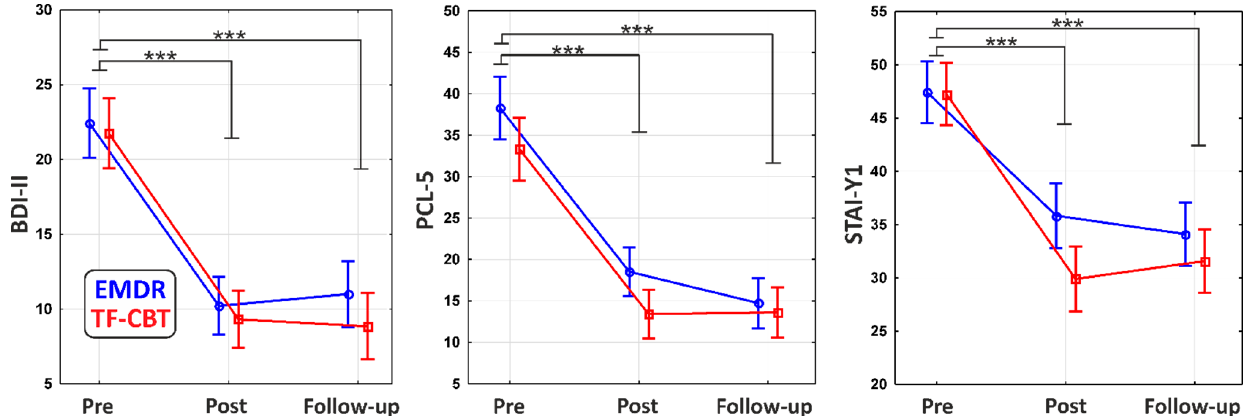
Figure 1. Mean scores of the Beck Depression Inventory-II (BDI-II, left ), post-traumatic stress disorder checklist for DSM-V (PCL-5, middle ) and State Trait Anxiety Inventory (STAI-Y1, right ) tests in the three time points for the EMDR (blue) and TF-CBT (red) groups. Vertical bars denote standard error of the means. *** p <